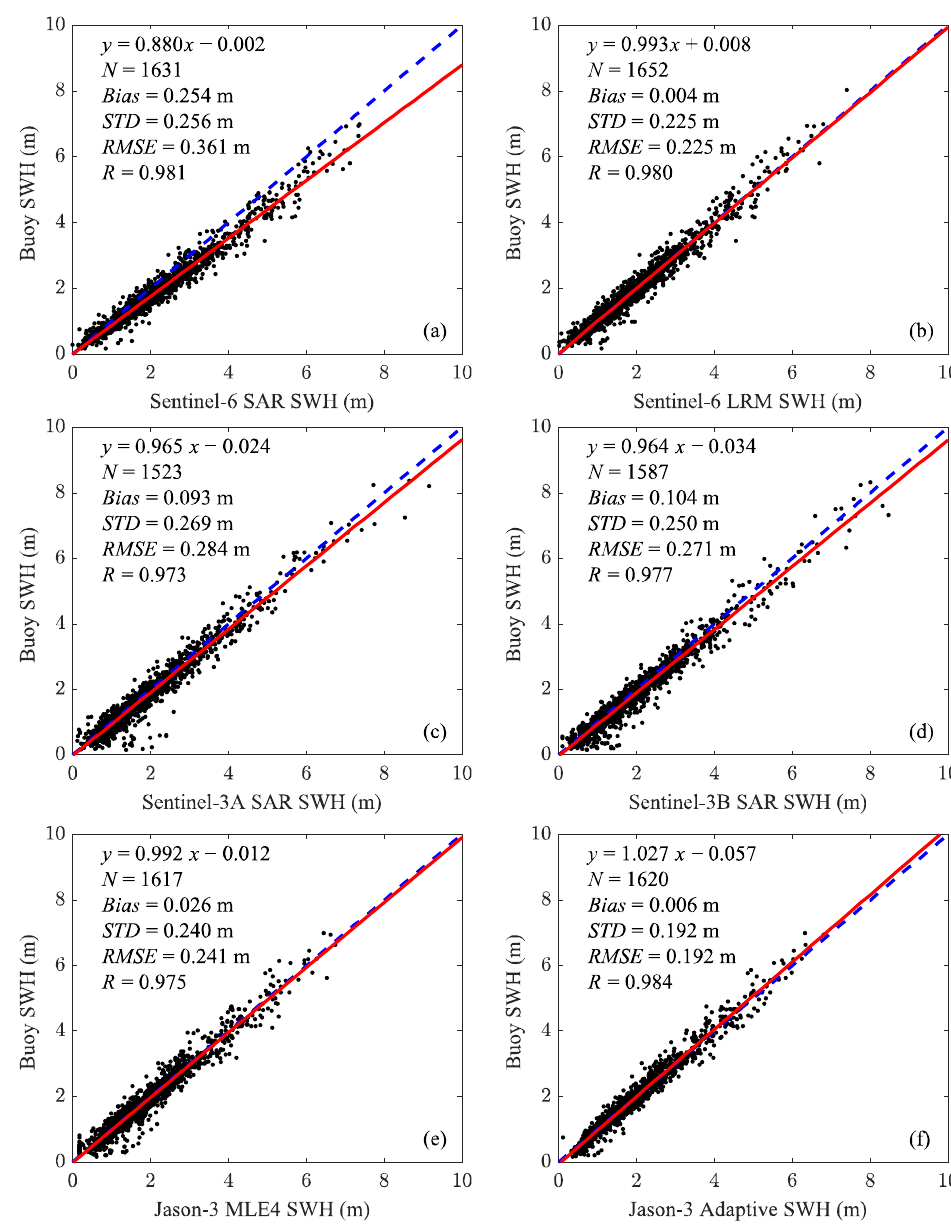
Figure 9. Scatterplots of ( a ) Sentinel-6 SARM, ( b ) Sentinel-6 LRM, ( c ) Sentinel-3A SARM, ( d ) Senti- nel-3B SARM, ( e ) Jason-3 MLE4 and ( f ) Jason-3 adaptive SWH measurements against the collocated NDBC buoys.